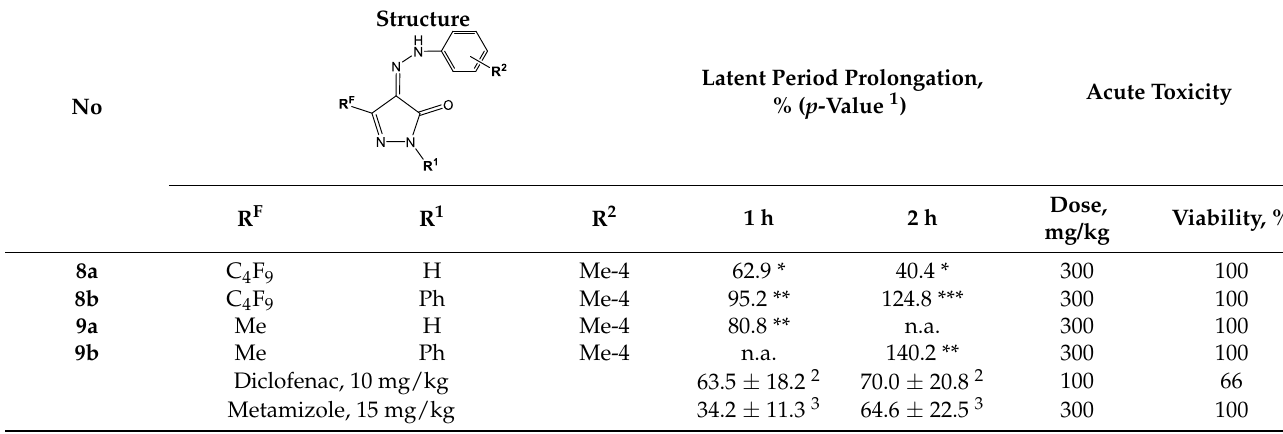
Table 8. Analgesic activity in hot plate test (dose 15 mg/kg, rats, ip ) and acute toxicity (three mice, Table 8. Cont. ip ) of 4-AHPs 5 –